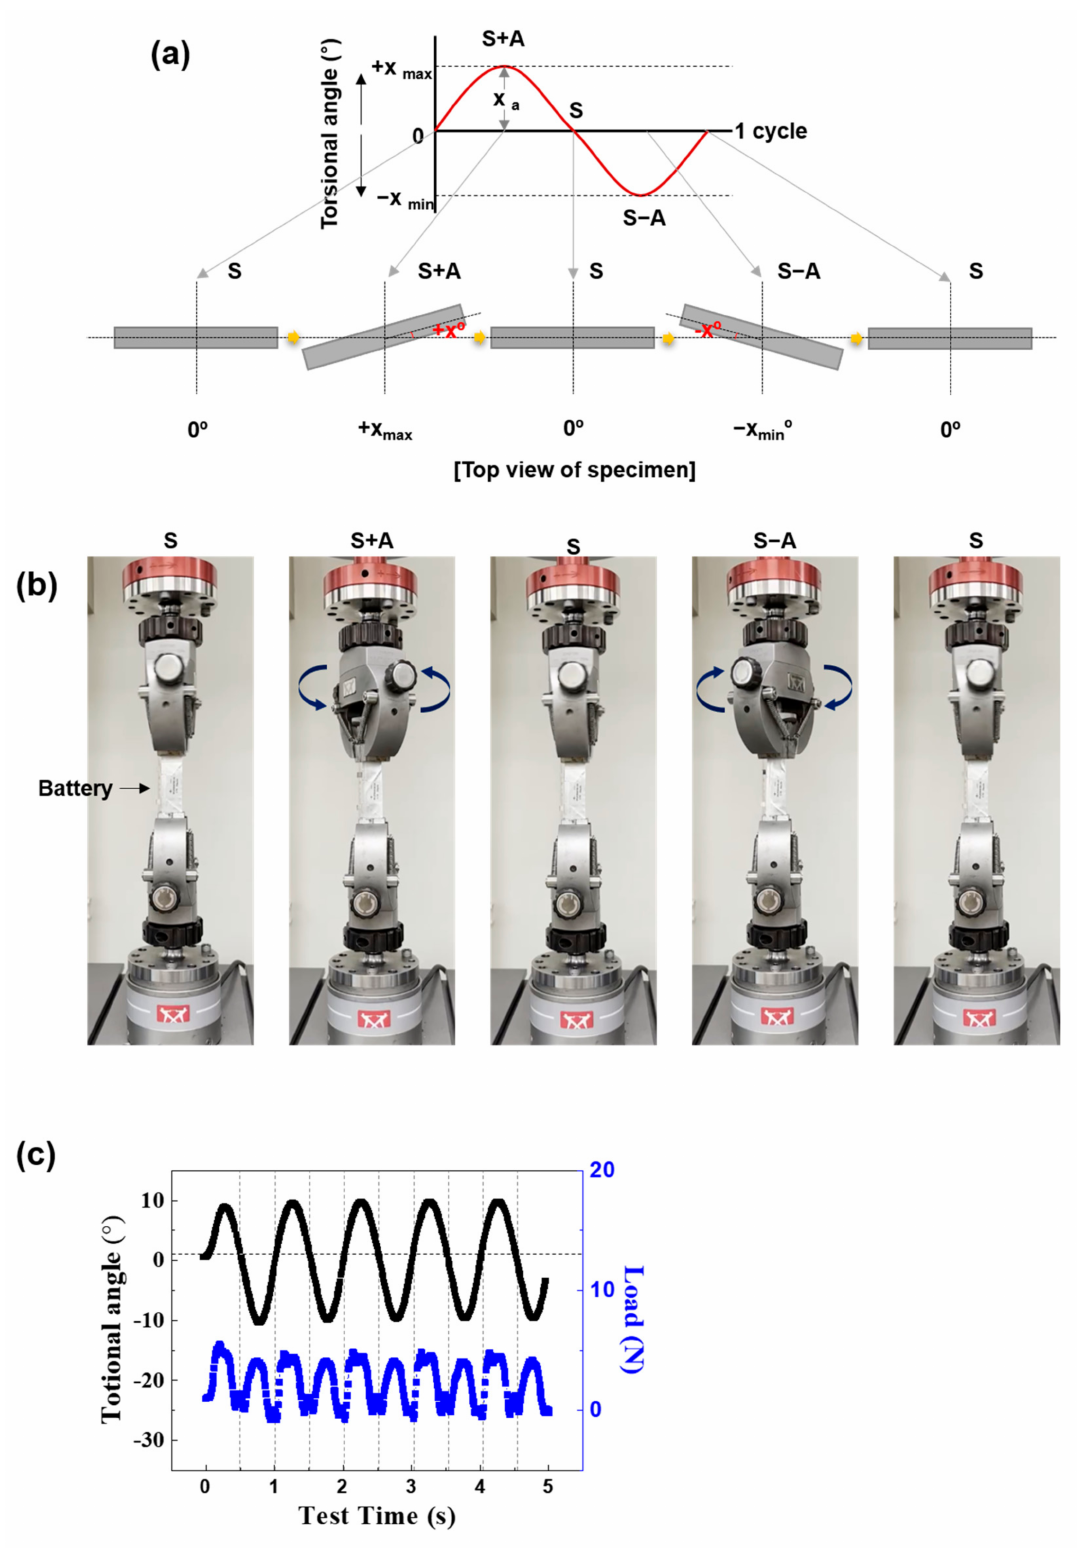
Figure 2. The torsional fatigue test conditions: ( a ) scheme of the phase changes in a sinusoidal wave, ( b ) torsional testing machine portraying the flexible conditions, and ( c ) fatigue load changes based on the rotation of the